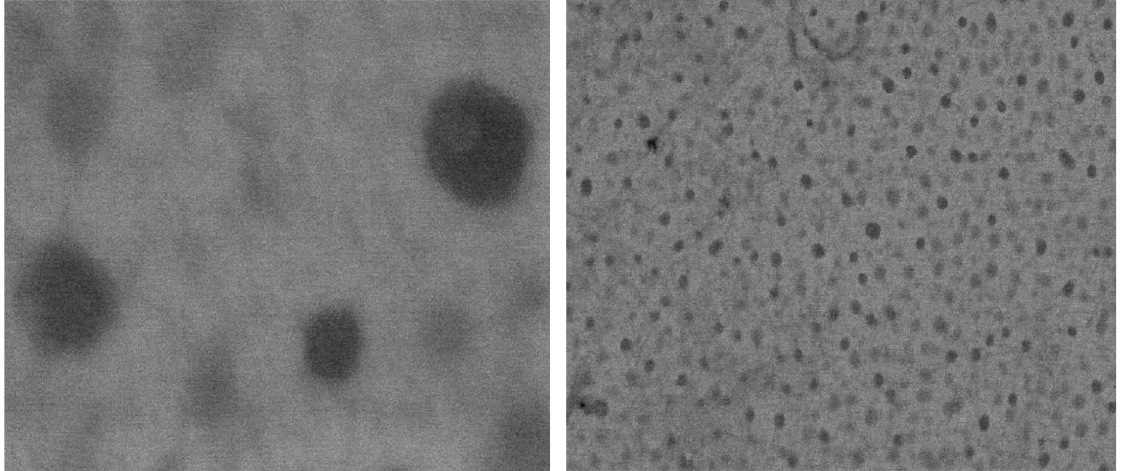
Fig 3. SEM images of SNEDDS formulation at different